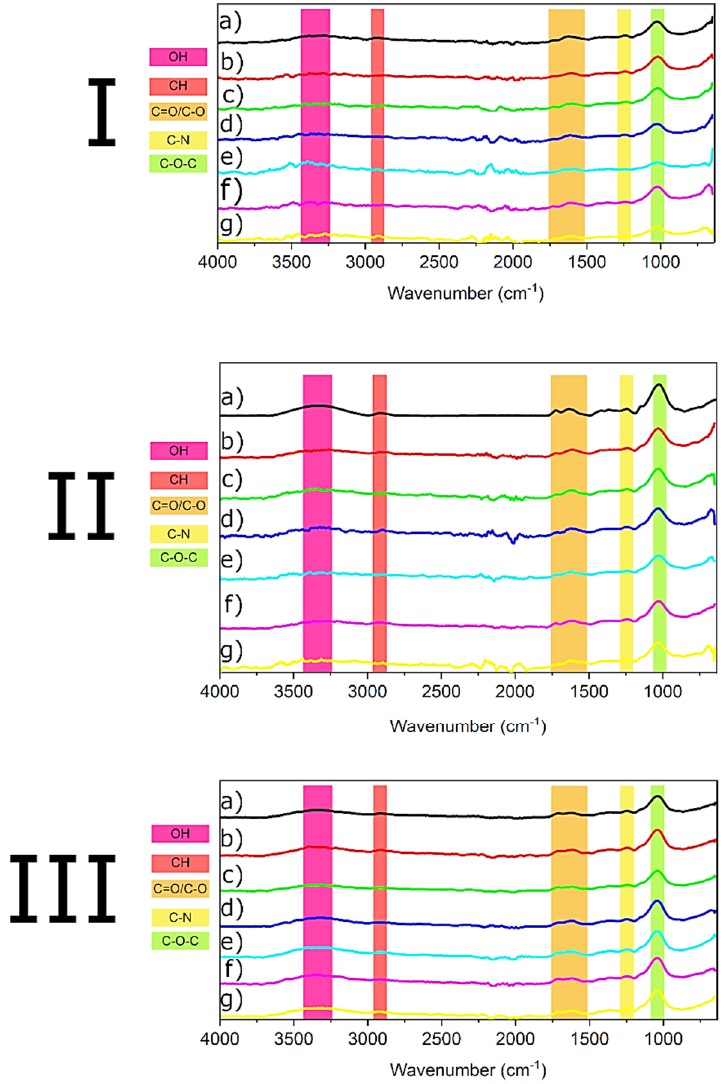
Figure 3. FTIR of ( I ) P. schreber i ( a ) before adsorption, ( b ) after Ni 2+ adsorption, ( c ) after Cu 2+ ad ‐ sorption, ( d ) after Zn 2+ adsorption, ( e ) after Cd 2+ adsorption, ( f ) after Pb 2+ adsorption, and ( g ) mix ‐ ture of cations. ( II ) D. polysetum ( a ) before adsorption, ( b ) after Ni 2+ adsorption, ( c ) after Cu 2+ ad ‐ sorption, ( d ) after Zn 2+ adsorption, ( e ) after Cd 2+ adsorption, ( f ) after Pb 2+ adsorption, and g) mix ‐ ture of cations. ( III ) S. fallax ( a ) before adsorption, ( b ) after Ni 2+ adsorption, ( c ) after Cu 2+ adsorp ‐ tion, ( d ) after Zn 2+ adsorption, ( e ) after Cd 2+ adsorption, ( f ) after Pb 2+ adsorption, and ( g ) mixture of cations.